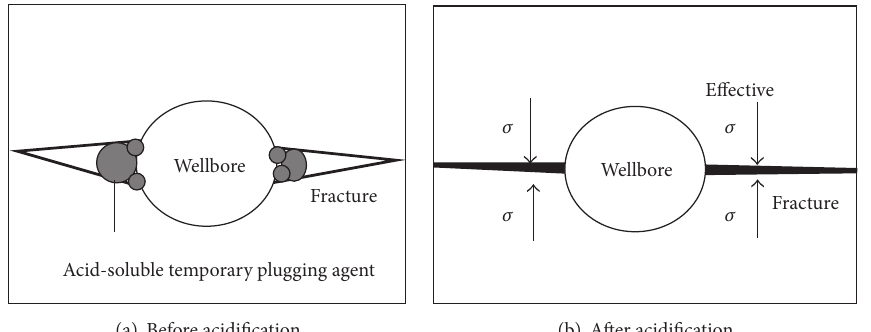
Figure 5: Fracture characteristics before and after dissolution of the temporary plugging agent in acid.